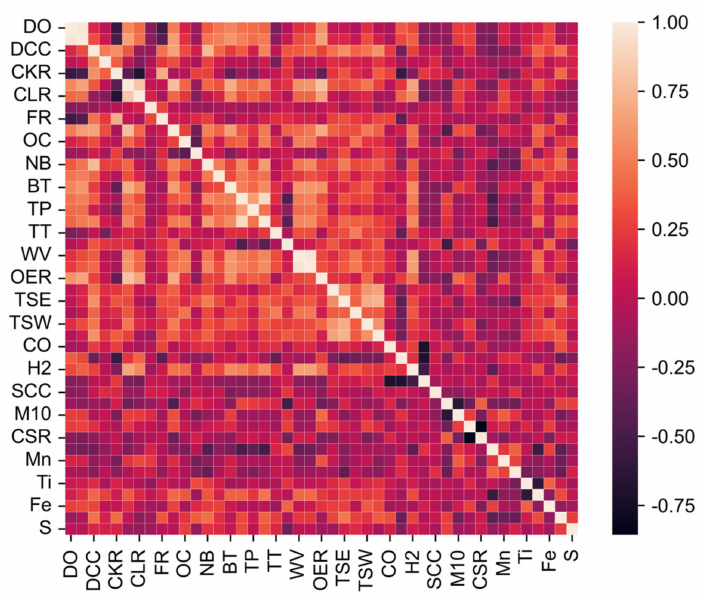
Figure 5. Heatmap of the Pearson correlation coefficient between each parameter.